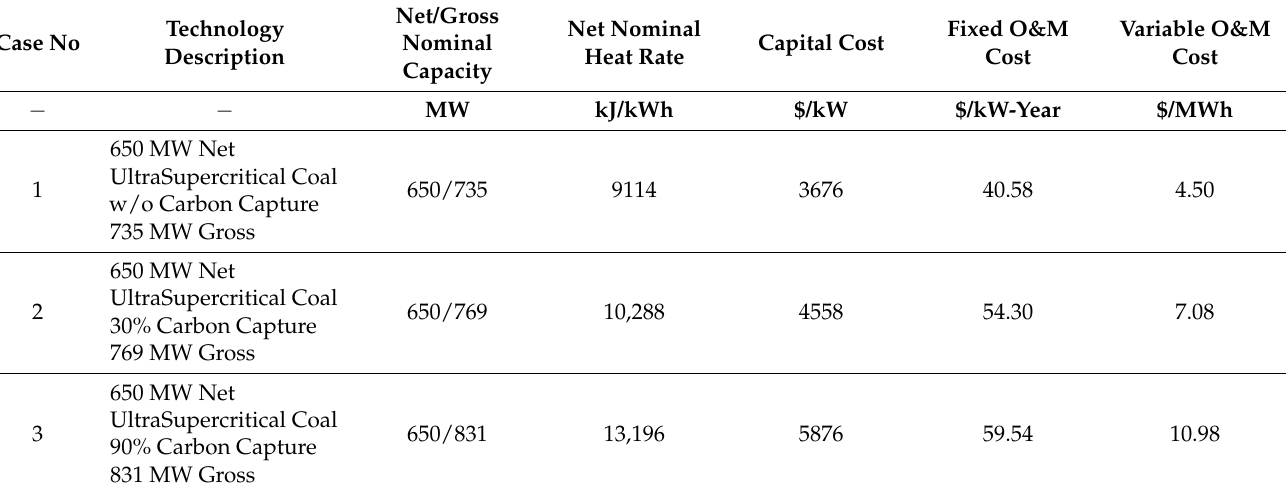
Table 4. Comparison for USC coal-fired power plants without and with carbon capture (Source: